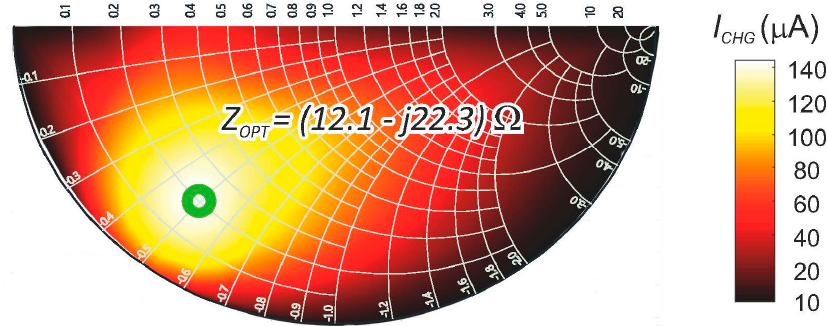
Figure 4. Loci for I CHG current as the results of source-pull procedure.